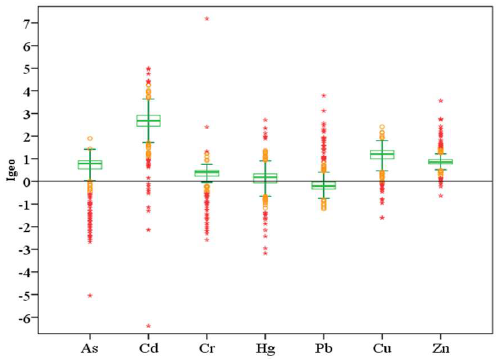
Figure 7. Igeo box plots for each element (N = 348).